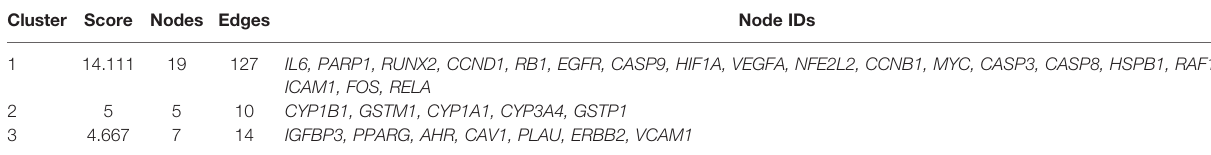
TABLE 2 | Cluster of target genes of quercetin and cisplatin anti-cervical cancer protein-protein interaction network. Cluster Score Nodes Edges Node